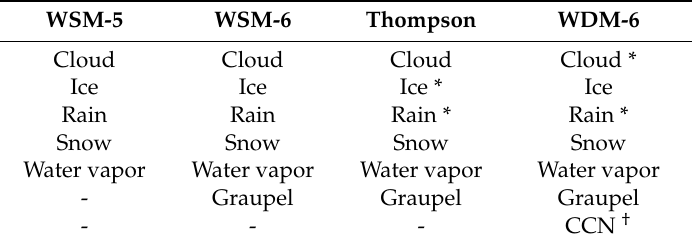
Table 1. WRF Microphysics Scheme Predicted Classes.